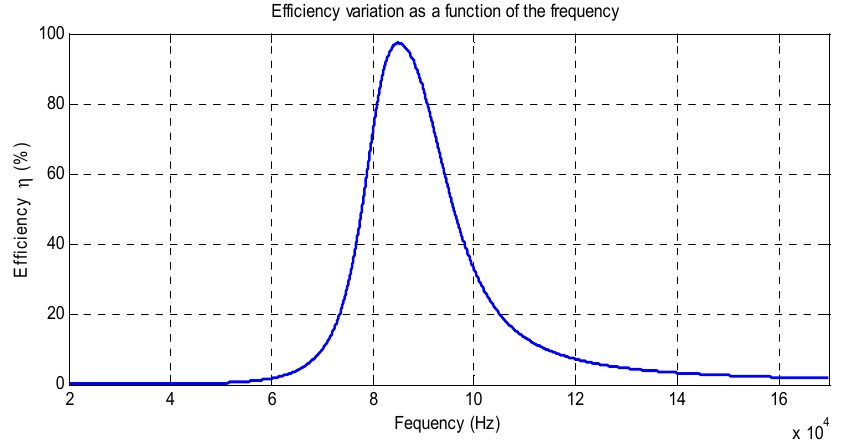
Figure 6. Efficiency variations of a WPT charger as a function of the frequency.